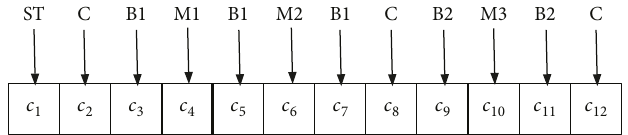
Figure 5: Linear array of cells resulting after discarding the representation of the activities of the